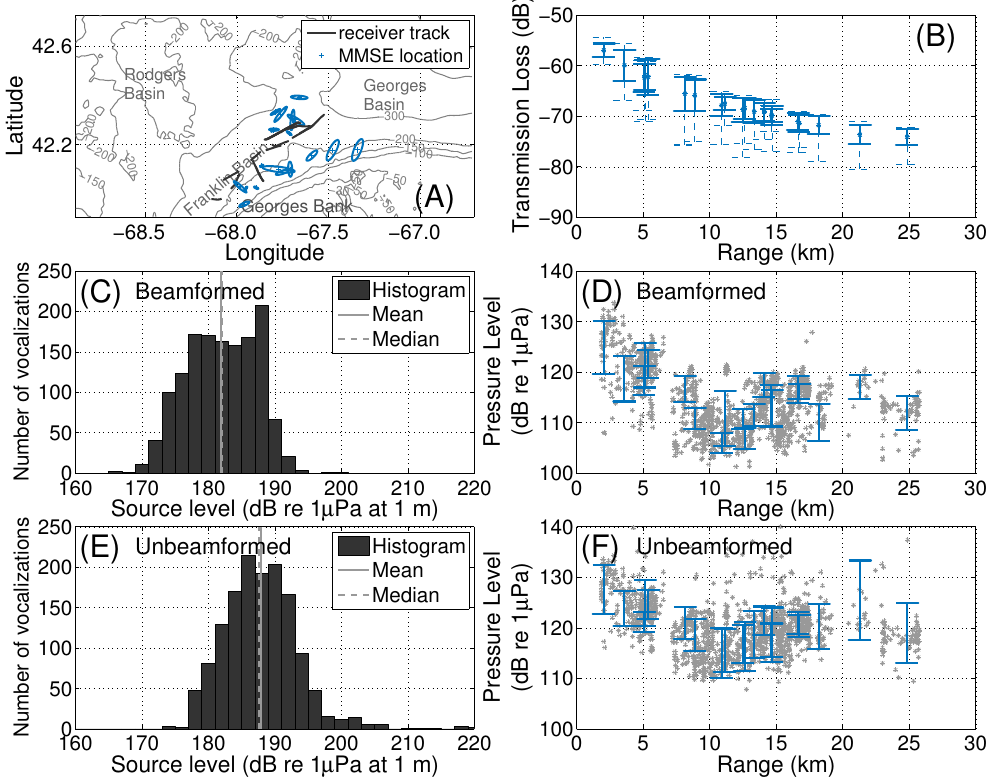
Figure 4. ( A ) The MMSE estimated center locations of sequences of fin whale vocalizations from 20 distinct bearing-time trajectories containing a total of 1410 vocalizations. The localization range and bearing errors are shown by the ellipse; ( B ) Corresponding one-way broadband transmission losses from the MMSE estimated fin whale vocalization sequence center locations to the POAWRS receiver array center. The transmission loss standard deviations (solid bar), minimum and maximum values (dotted bar) are calculated assuming the whales are located at each potential depth from the sea surface to near the seafloor; ( C ) Distribution of fin whale vocalization source level derived from bandpass-filtered beamformed signals has a mean of 181.9 ± 5.2 dB re 1 µ Pa at 1 m; ( D ) The received fin whale vocalization pressure levels estimated from beamformed data are plotted as a function of distance from estimated instantaneous MAT locations of each vocalization to the receiver array center. These data are used to derive the source level distribution shown in ( C ); ( E ) Distribution of fin whale vocalization source level derived from bandpass-filtered unbeamformed signals has a mean of 187.9 ± 5.6 dB re 1 µ Pa at 1 m; ( F ) The maximum value of the fin whale vocalization pressure levels received on 160 hydrophone elements of the POAWRS receiver array used to derive the source level distribution shown in ( E ). The blue bars in ( D , F ) represent one standard deviation in the pressure levels for each bearing-time